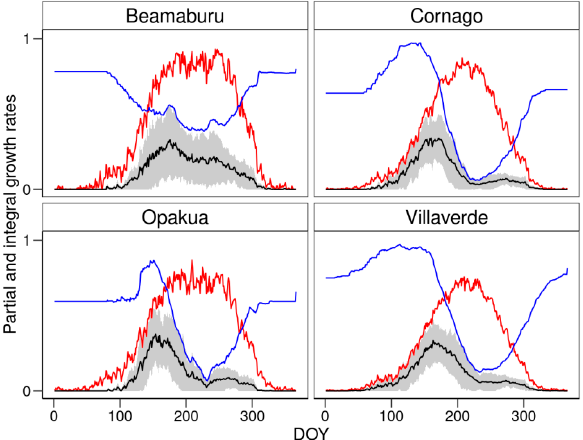
Figure 7. Simulated partial growth rates due to temperature (GrT, red lines) and soil moisture limitations (GrM, blue lines) and integral growth rates (Gr, black lines) averaged during the simulation period for each site. The grey lines show the standard deviations of the integral growth rates. DOY is the day of year.